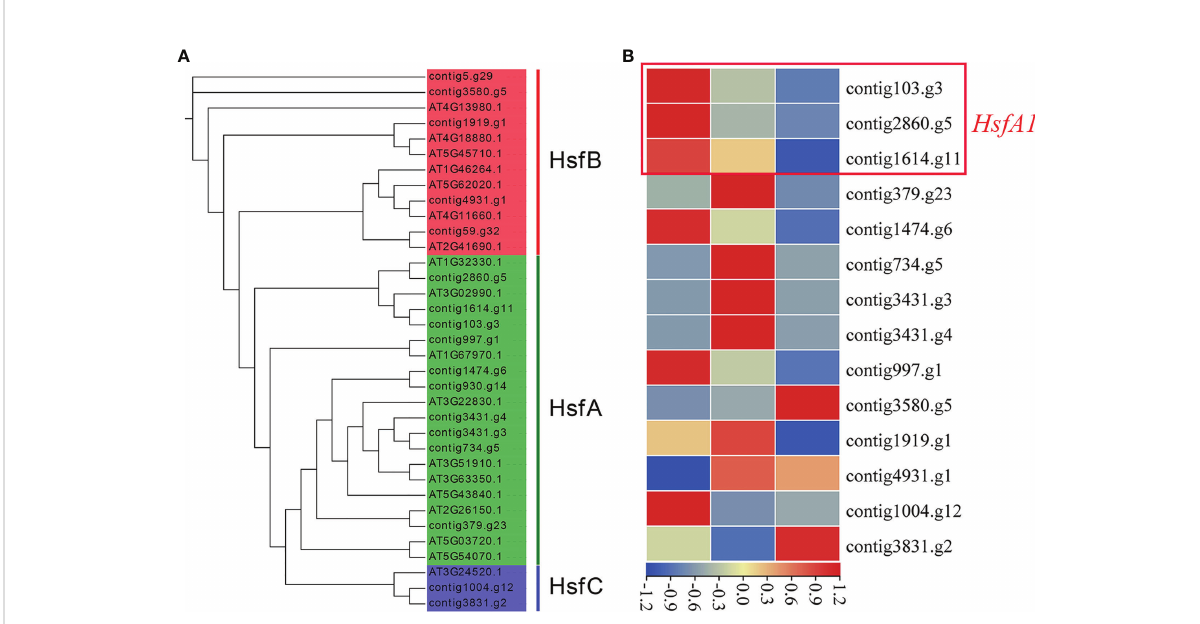
FIGURE 2 Phylogenetic analysis of Hsf transcriptional factors identi fi ed in the J . sambac cultivar JSDB and A . thaliana genomes (A) and the expression of Hsfs in the three fl oral developmental stages of J . sambac cultivar JSDB (B) . S1, young fl oral bud stage; S2, mature fl oral bud stage; S3, initial opening fl ower